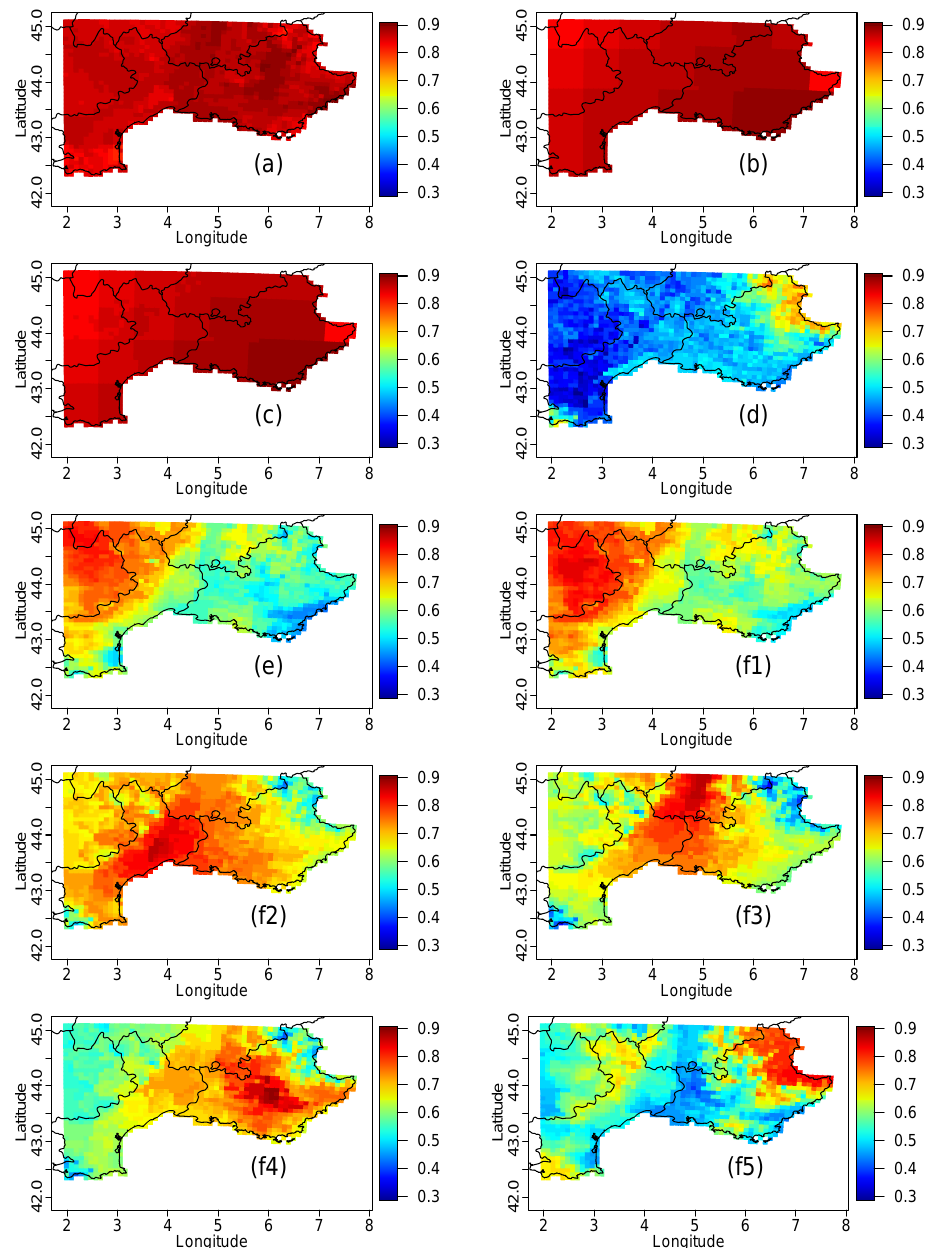
Figure 6. Maps of lag-1 day temperature auto-correlations in winter over the evaluation period for (a) SAFRAN; (b) ERA-I; (c) 1d- BC; (d) 2d-R 2 D 2 (with PR as ref.dim. for each grid cell); (e) 1506d-R 2 D 2 ; (f1–5) 3012d-R 2 D 2 with five different reference temperature